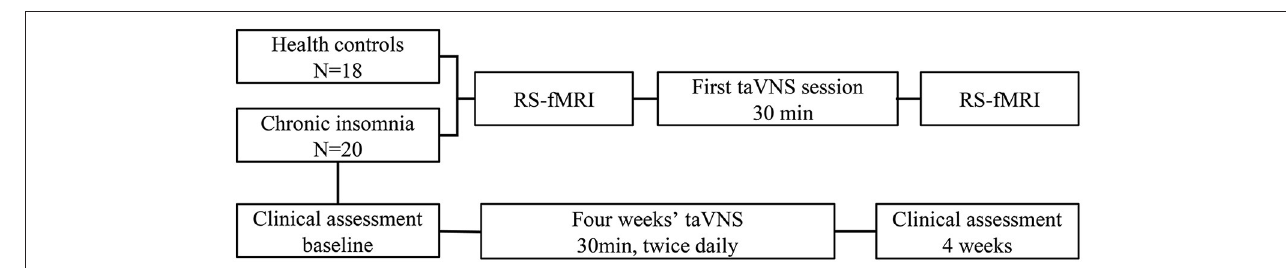
FIGURE 2 | Changes of fMRI induced by instant taVNS were measured before and after the first treatment on the two groups. Clinical scales for patients were assessed before and after the 4 weeks’ taVNS treatment.